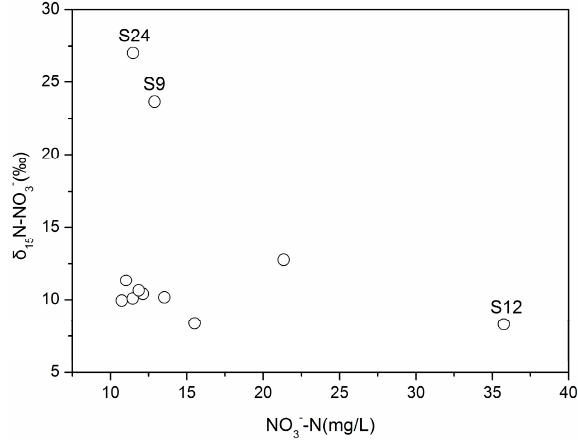
´ -N and δ 15 N-NO ´ in surface 3 3